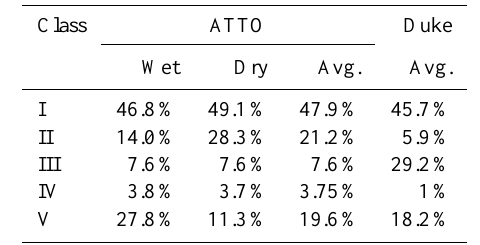
Table 5. Percentage of occurrence of Cava’s classes for dry and wet season obtained at the ATTO site and a comparison with the results found by Cava for the Duke Forest, North Carolina,